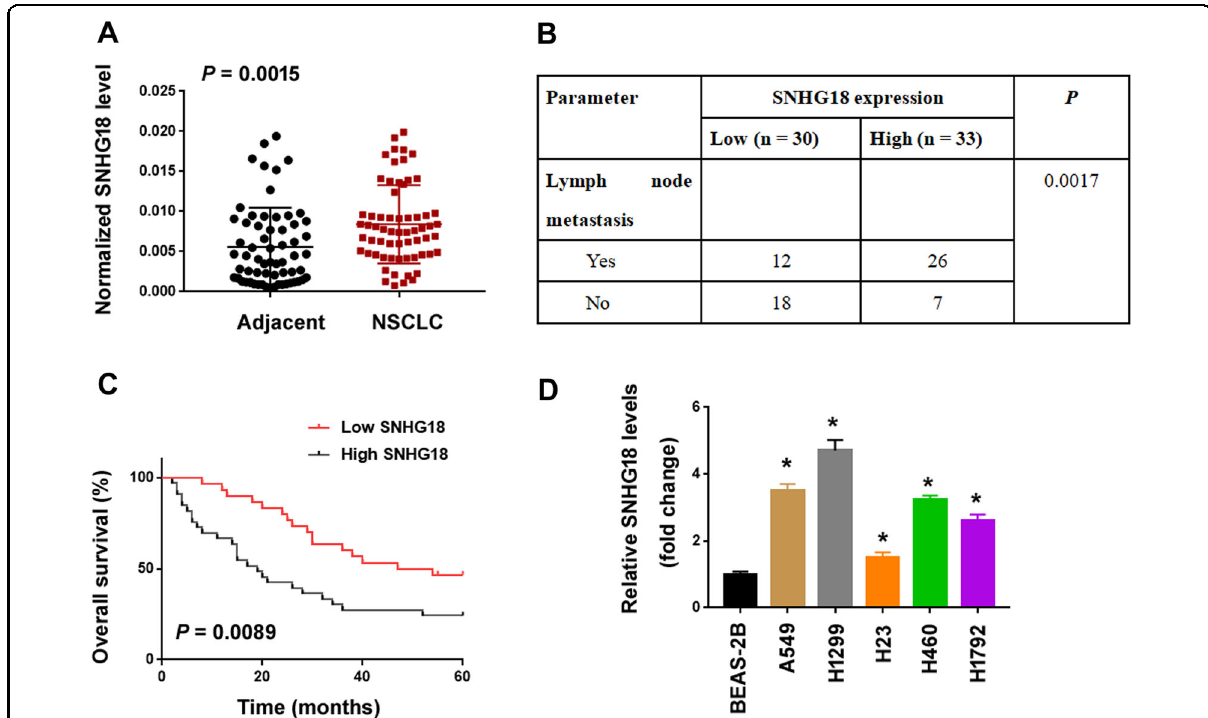
Fig. 2 SNHG18 is upregulated and predicts poor prognosis in NSCLC. A Relative SNHG18 expression measured in 63 paired NSCLC and adjacent noncancerous tissues. P value, Student ’ s t -test. B Analysis of the relationship between SNHG18 expression and lymph node metastasis. C Kaplan – Meier survival curves were performed to determine the impact of SNHG18 expression on the overall survival of NSCLC patients. P value, log-rank test. D SNHG18 levels in NSCLC cell lines and BEAS-2B lung epithelial cells analyzed by quantitative PCR. * P < 0.05 vs. BEAS-2B, one-way ANOVA followed by Bonferroni ’ s test.